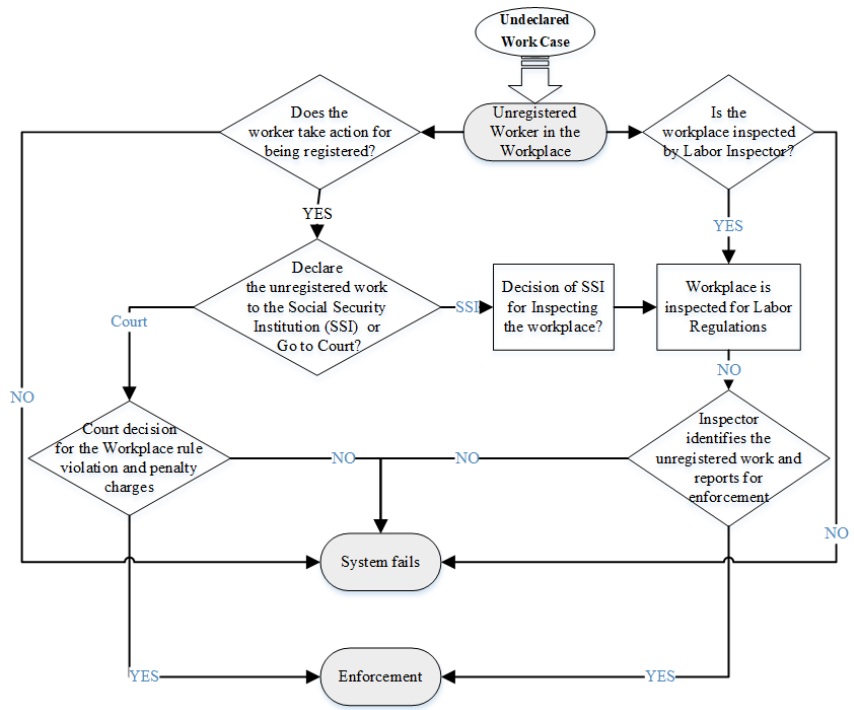
Figure 4. Flowchart of the Unregistered Workers Case Process in the OHS Institutional System.